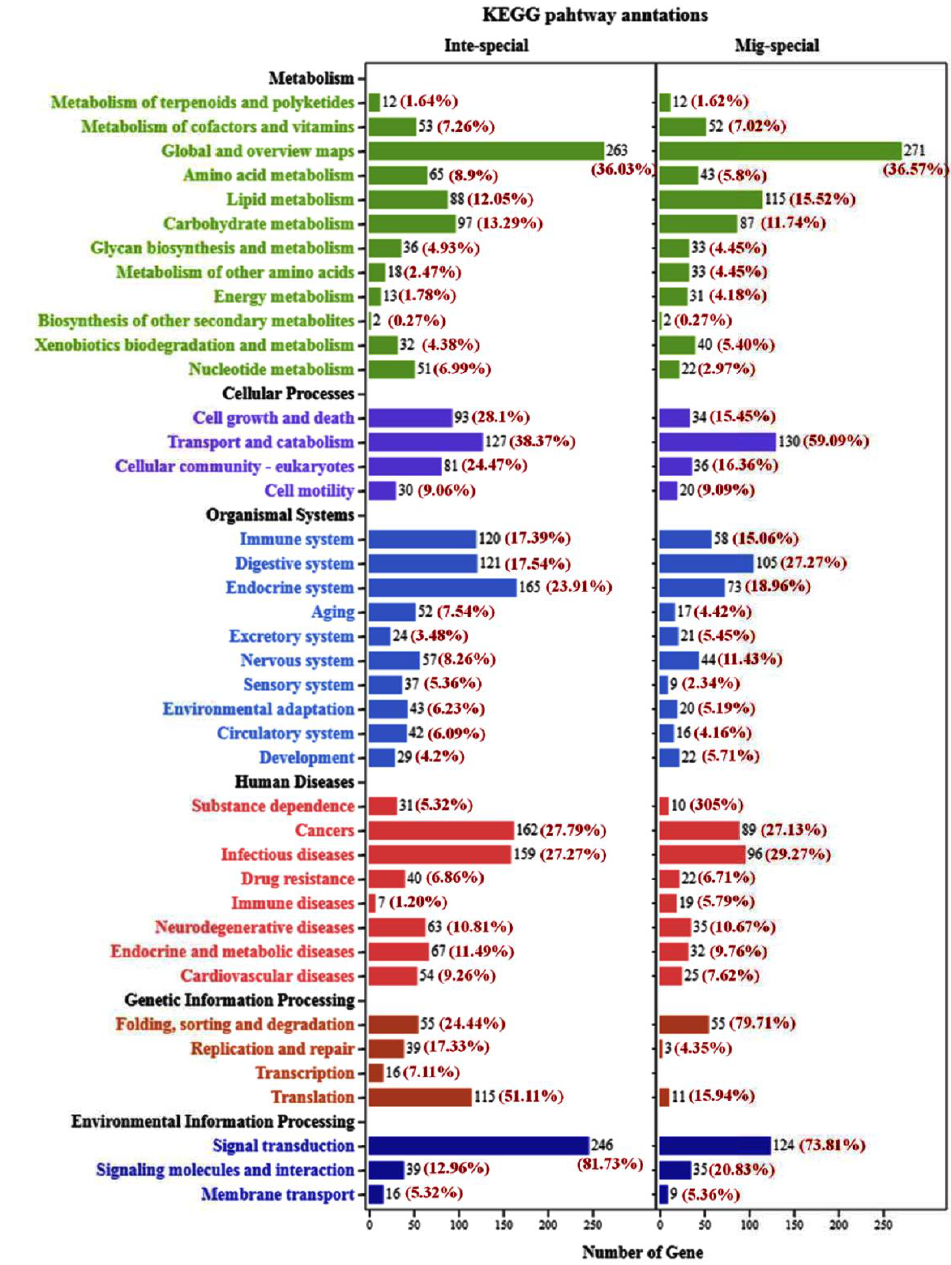
Figure 1. The KEGG analysis of differentially expressed genes between integument and midgut. Genes with RPKM ≥1 and the ratio between integument and midgut ≥2 were selected for comparative